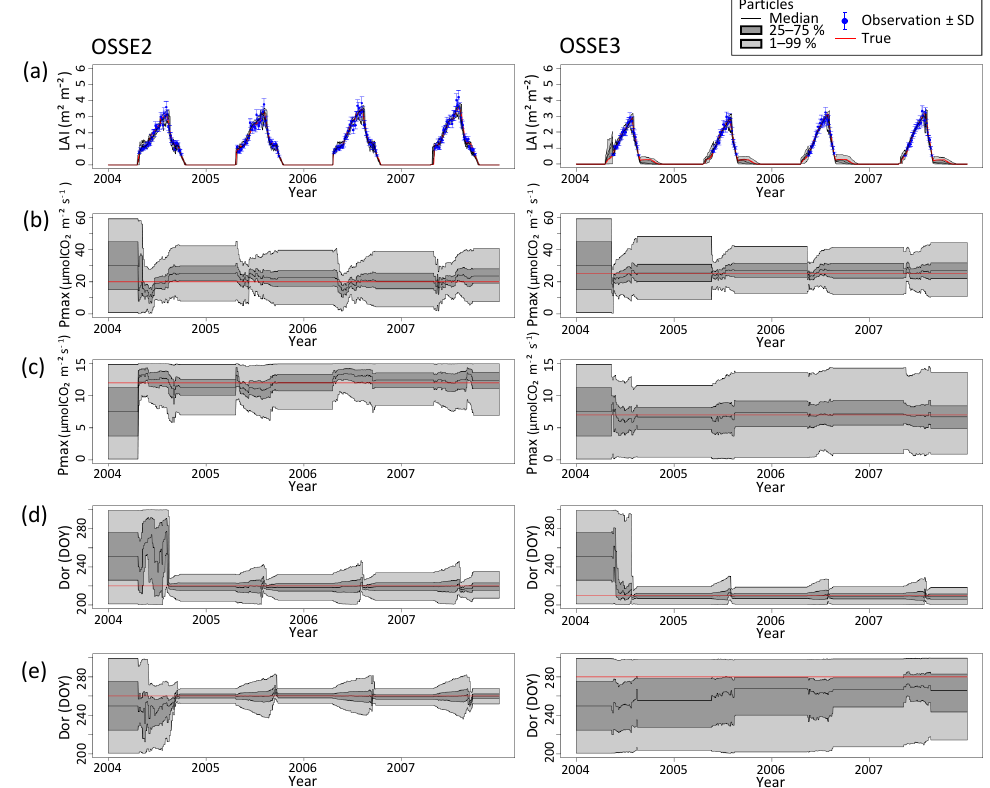
Figure 6. Similar to Figs. 3 and 4 but for OSSE2 (left) and OSSE3 (right). (a) Time series of LAI for tree plus grass, (b) Pmax for tree, (c) Pmax for grass, (d) Dor for tree, and (e) Dor for grass.